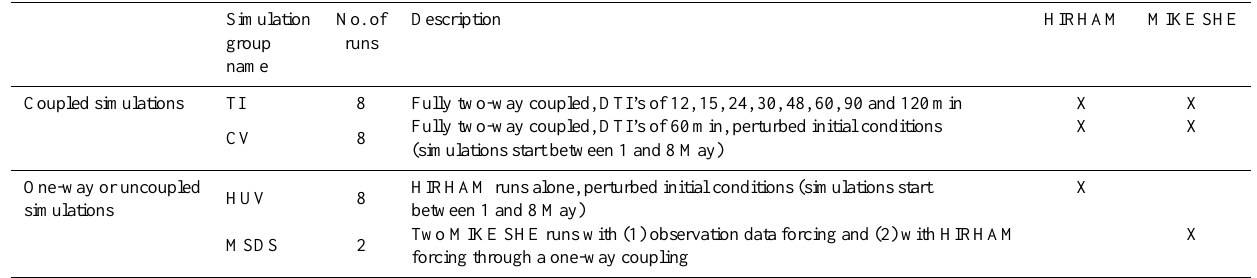
Table 1. Simulation outline showing simulation groups, number of runs in each group and short description of simulation group characteris- tics. The two latter columns show from which of the two model components the simulation output derives. Simulation No. of